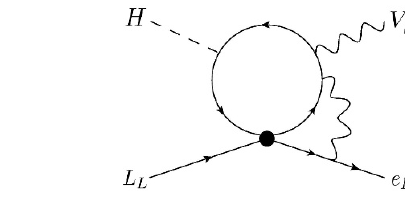
and at the two-loop O eW O eB